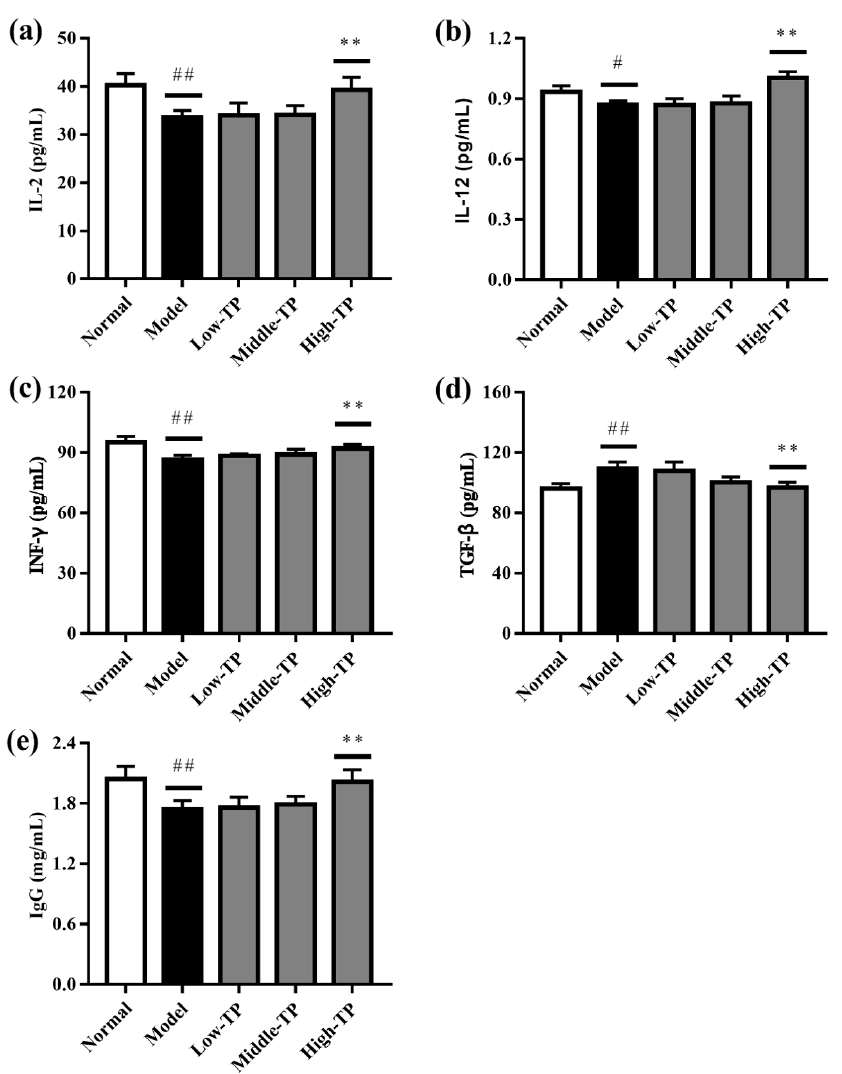
Figure 4. Effect of TP on IL-2 ( a ); IL-12 ( b ); INF- γ ( c ); TGF- β ( d ) and Ig G ( e ). # p < 0.05 versus Normal. ## p < 0.01 versus Normal. ** p < 0.01 versus Model. ## p < 0.01 versus Normal. ** p < 0.01 versus